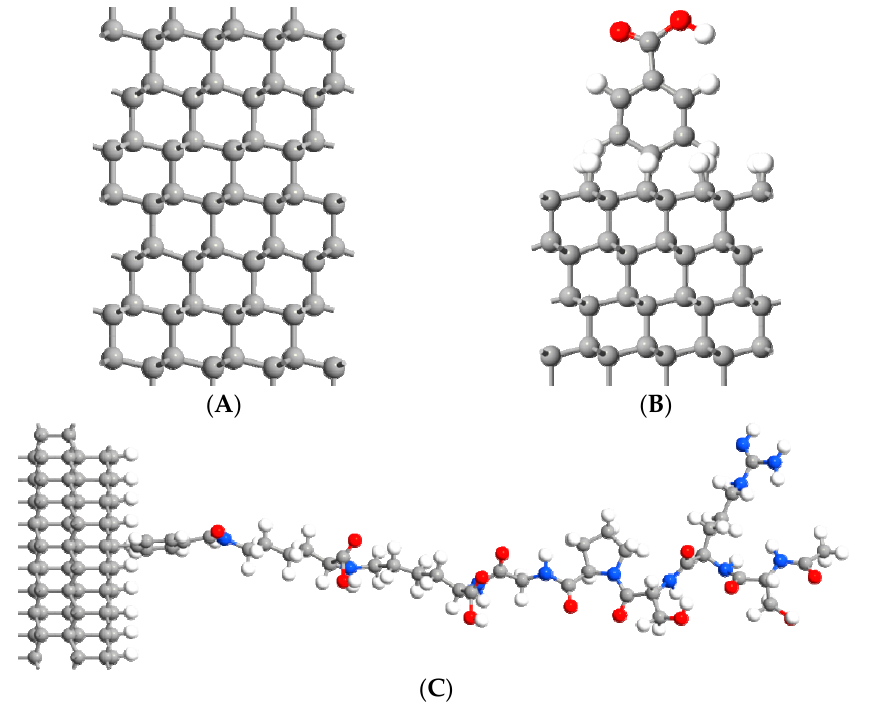
Figure 1. Optimized (4 × 4) model structures: ( A )—(BDDE) relaxed boron-doped diamond (111); ( B )—(BDDE-H-ABA)-H-terminated reconstructed boron-doped diamond (111) with adlayer of 4-amino-benzoic acid; ( C ) (BDDE-H-ABA-C3M)-H-terminated reconstructed boron-doped diamond (111) with 4-amino benzoic acid and ligand ending.